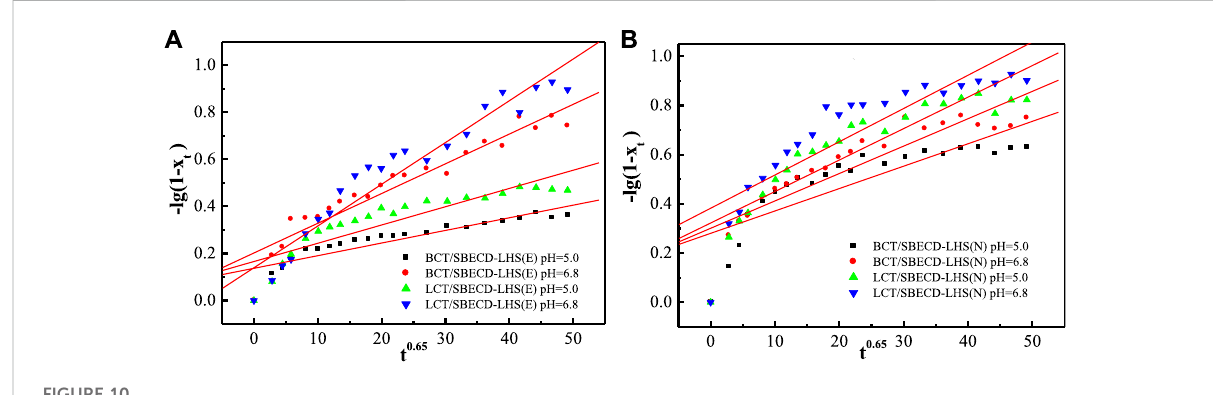
FIGURE 10 Regression curves of release data fi tting with Bhaskar model for DHS-hybrids (E) and LHS-hybrids (N) in different mediums.